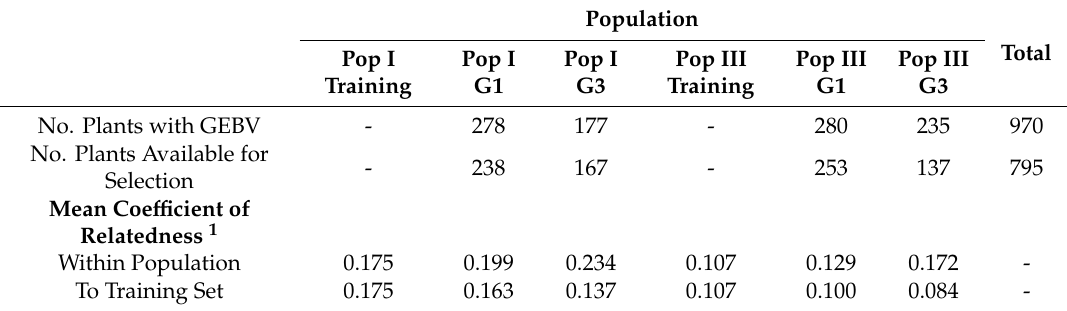
Table 1. Summary data for selection populations Pop I G1 and G3 and Pop III G1 and G3,